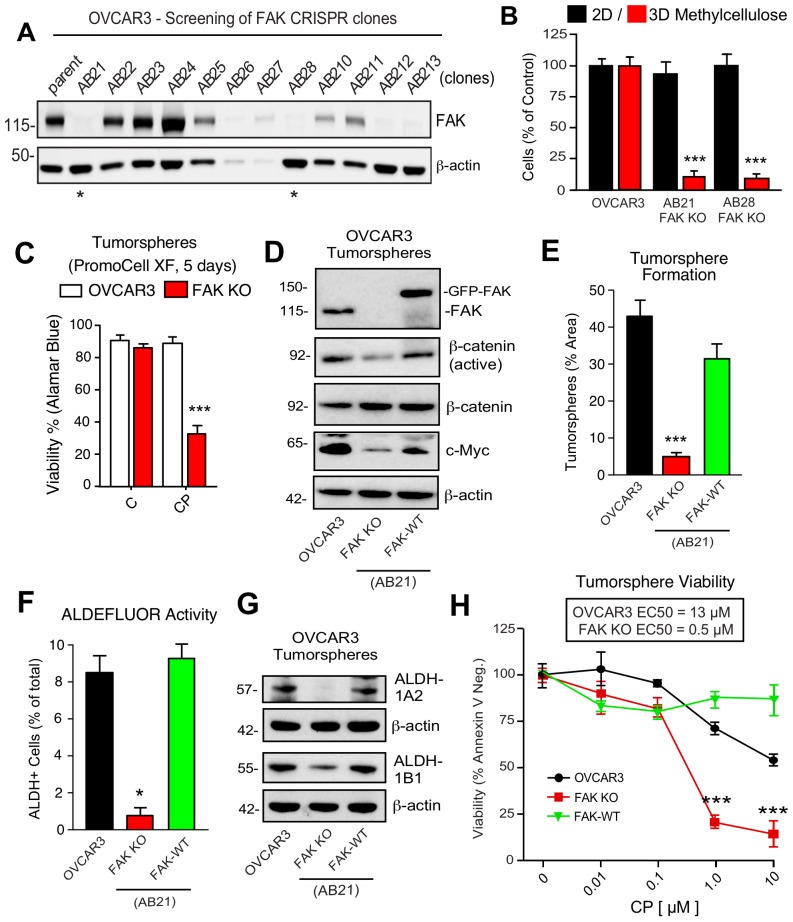
OVCAR3 CRISPR-mediated FAK KO and re-expression.(A) Immunoblotting for FAK and actin in OVCAR3 lysates and identification of FAK KO clones (AB21 and AB28 are starred). (B) Growth of OVCAR3 parental, AB21, and AB28 cells in 2D culture (black bars) or enumeration of colonies in methylcellulose after 14 days (red bars). Values are means as percent of OVCAR3 control (± SEM, ***p<0.001, one-way ANOVA or NS, not significant) from two independent experiments. (C) Cell viability treated with DMSO (control) or CP (1 µM) after 72 hr as measured by AlamarBlue. Values are means (± SEM, *p<0.05, ***p<0.001) for three independent experiments. (D) Immunoblotting for FAK, active β-catenin, β-catenin, Myc, and actin in the indicated cell lysates from 3D conditions. (E) Tumorsphere formation (5 days). (F) ALDEFLUOR activity. (E and F) Values are means (± SEM, n = 2, *p<0.05, ***p<0.001, one-way ANOVA with a Tukey’s multiple comparisons test) from three (panel E) or four (panel F) independent experiments. (G) Immunoblotting for ALDH-1A2, ALDH-1B1, or actin in the indicated cell lysates. (H) Cytotoxicity (percent Annexin V negative) of OVCAR3 (black circles), OVCAR3 FAK KO (red squares), and OVCAR3 FAK KO + GFP-FAK-WT (green triangles) cells in PromoCell treated with increasing CP concentrations for 5 days. Values are means (± SEM, ***p<0.001, two-way ANOVA with a Bonferroni’s multiple comparisons test) from three independent experiments. EC50 values were determined independently and calculated using Prism (Graphpad).